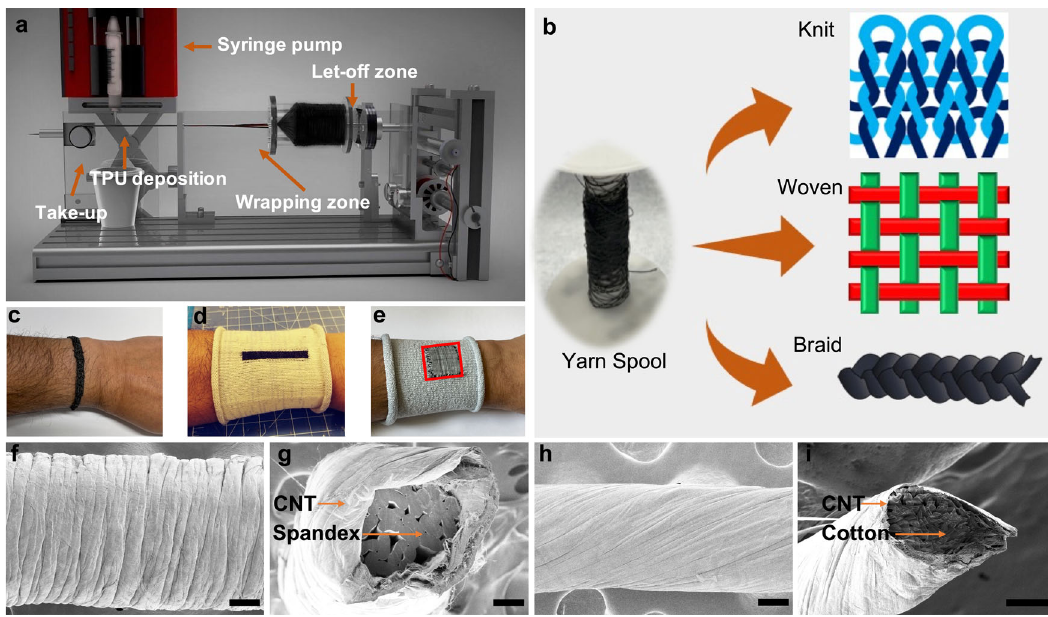
Fig. 1 CNT Yarn and Textile Fabrication. a Fabrication schematic of the CNT wrapped textile yarn spinning system. Two CNT sheets are attached in the let-off zone and wrapped over core yarn in the wrapping zone. TPU is deposited on the CNTs wrapped yarn surface before winding in take up roller. b Different textile processing methods for producing fabric electrodes. The inset shows a spool of CNT wrapped yarn used for the electrodes. Fabric electrodes produced including c braided d knitted and e woven electrode (outlined in red) sewn on a wrist band f – i The surface and cross-sectional morphology of the CNT-Spandex-TPU (Fig. 1f, g) and CNT-Cotton-TPU (Fig. 1h, i). The scale bar of the SEM images are 100